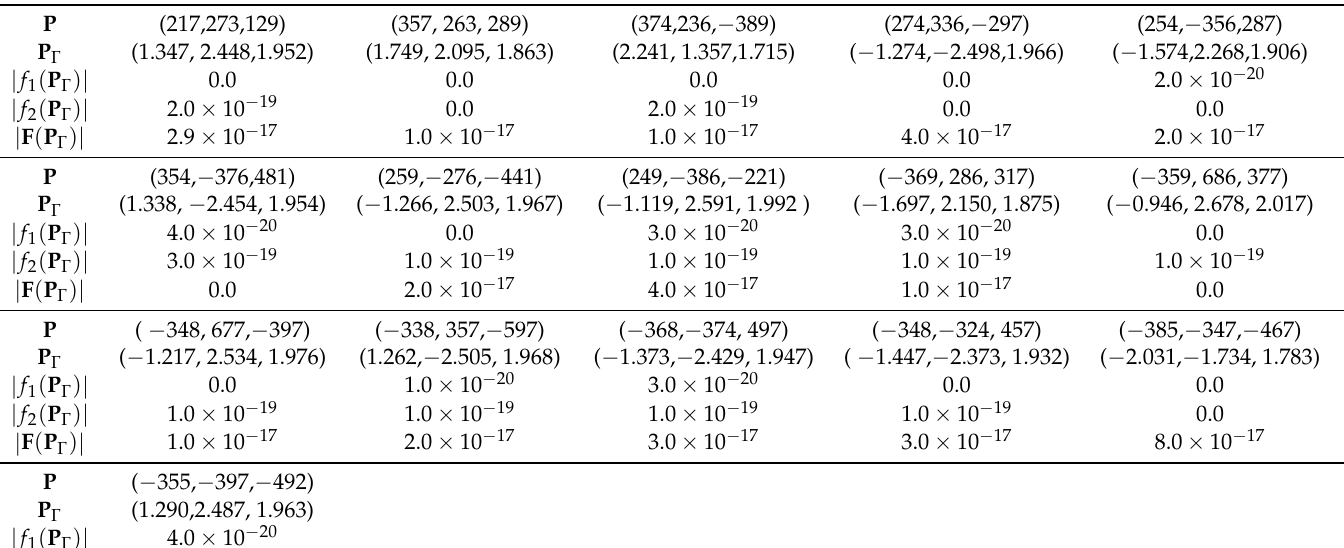
Table 1. Test results of Algorithm 4 for Example